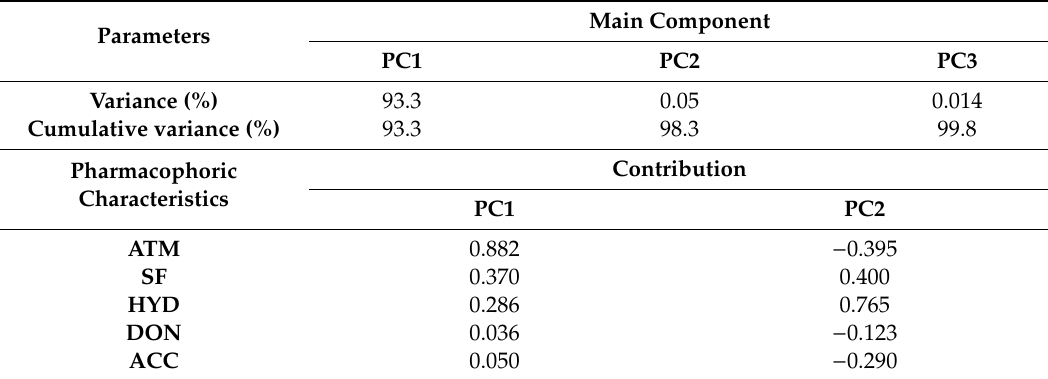
Table 2. Main components of the analysis and contribution of pharmacophoric characteristics based on multivariate principal component analysis